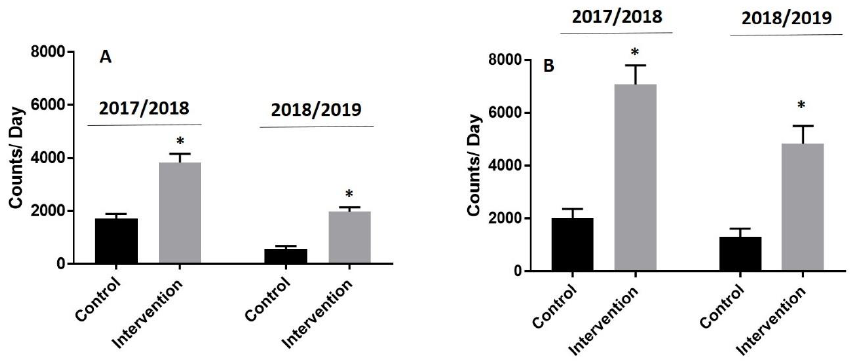
Figure 5. Mean daily trail visits during intervention and control periods stratified by type of day. A = weekday day; B = weekend day; * = p < 0.001.